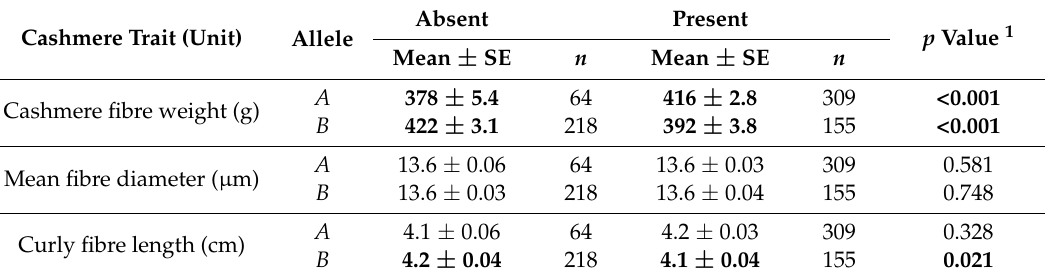
Table 4. Association of KRTAP20-2 alleles with various cashmere traits (Mean ± SE) 1 in Longdong cashmere goats.